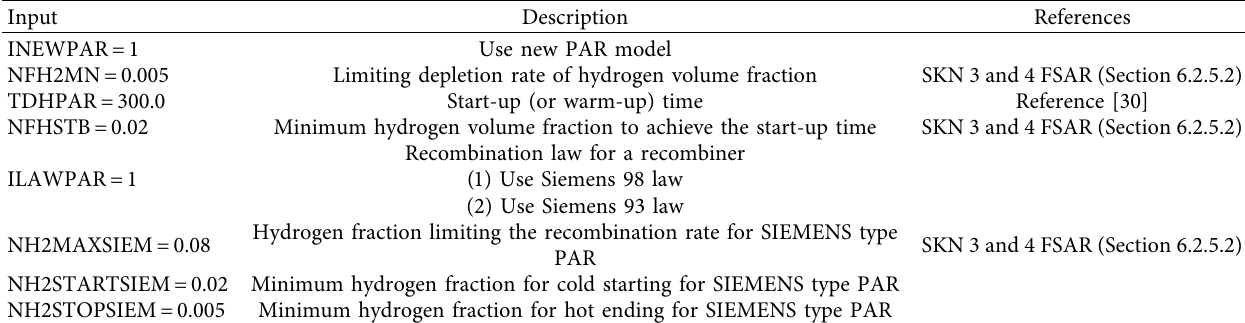
Table 2: Key input parameters for PAR.